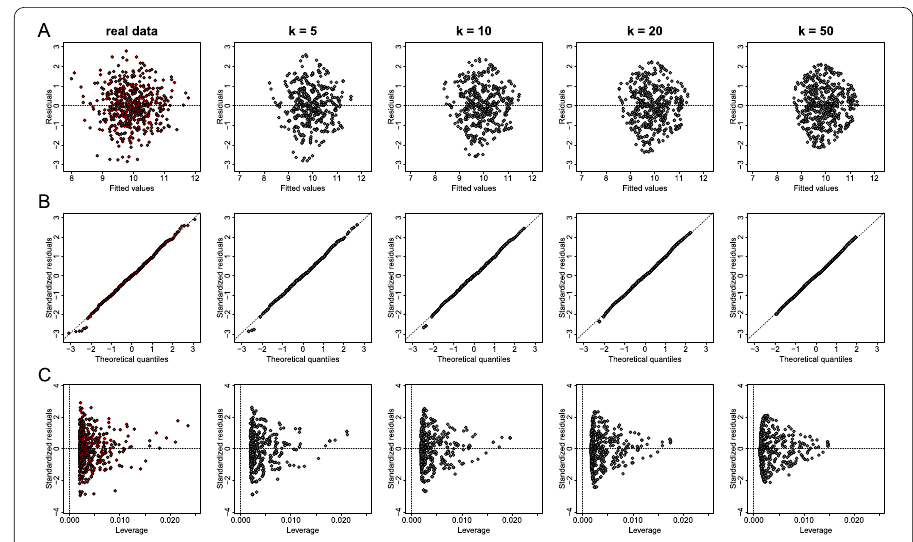
Figure 13 The effect of parameter k of the deterministic anonymization method on regression plot diagnostics. From left to right we demonstrate the effect of k for the values of 1 (this is equivalent to the real data), 5, 10, 20 and 50 on generating privacy-preserving residuals vs fitted values plots ( A ), normal QQ plots ( B ), and standardized residuals vs leverage ( C